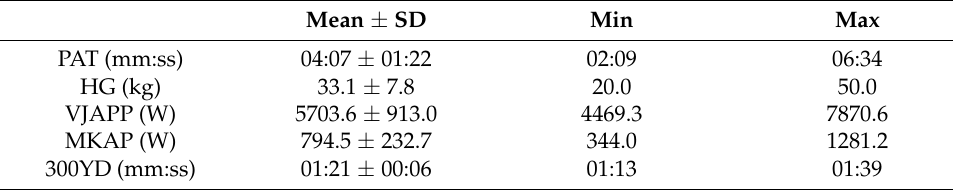
Table 2. Descriptive Statistics—PAT Scores and AF